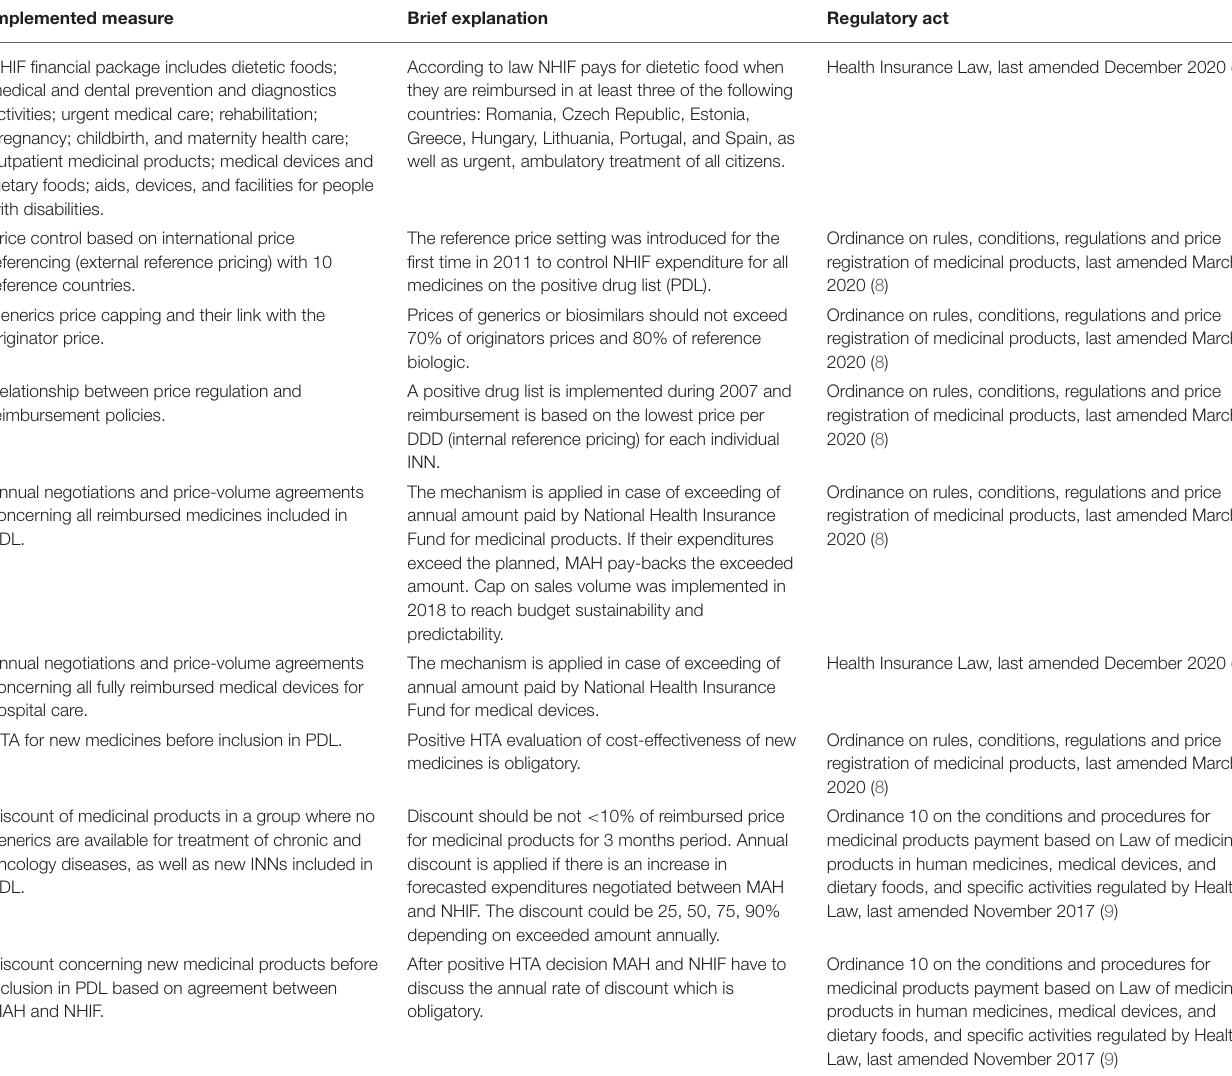
TABLE 2 | Cost containment measures available and actual in January 2021 in Bulgaria.